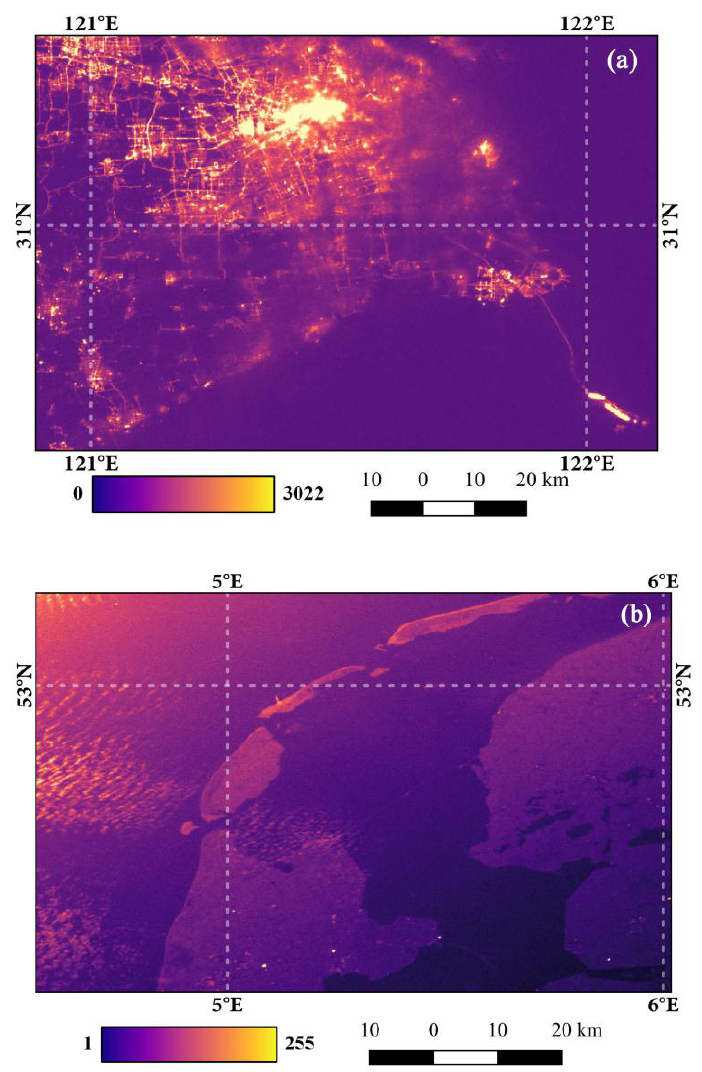
Figure 13. The quality of Luojia 1-01 nighttime light imagery with clouds and a full moon: ( a ) refers to the nighttime light imagery with clouds in Shanghai, China; ( b ) refers to the nighttime light imagery with a full moon near Amsterdam, the Netherlands.